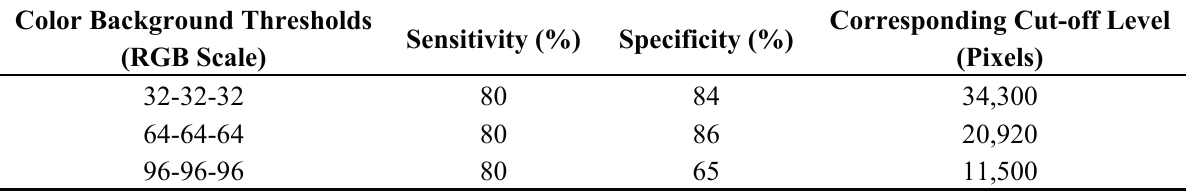
Table 2. Sensitivity and specificity values of the nest usage sensor evaluated for different color background (CB)